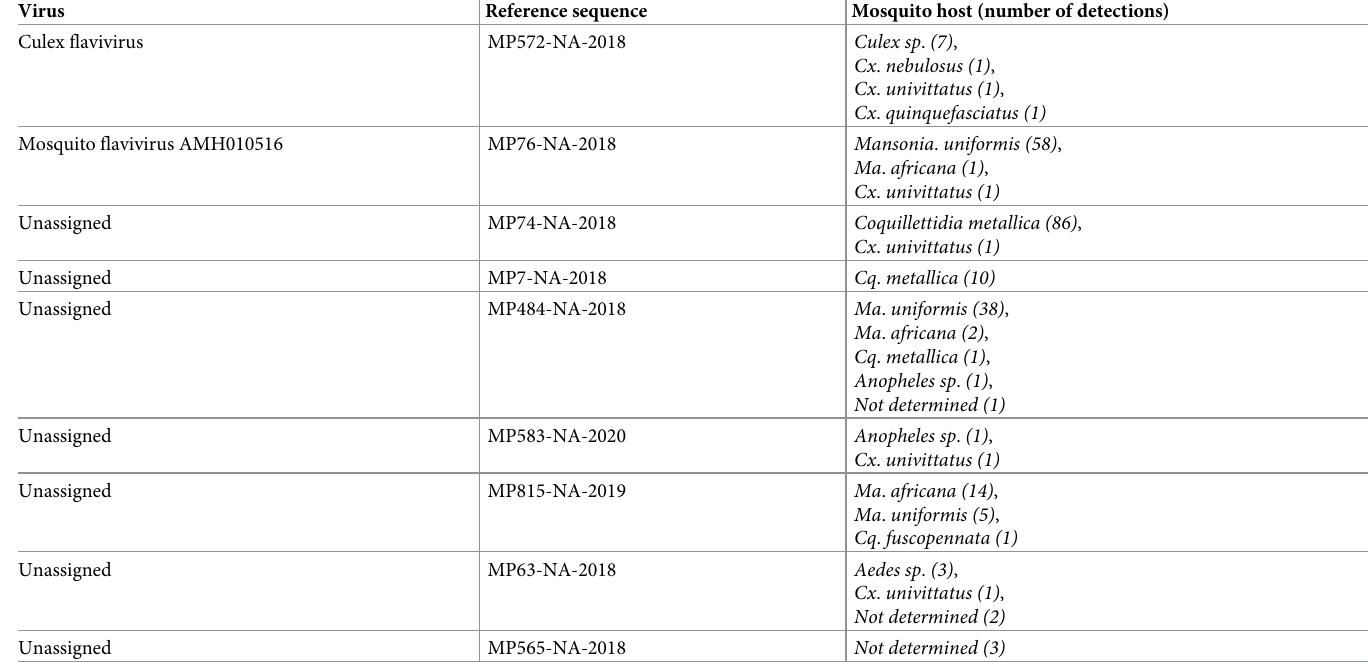
Table 1. Detected insect-specific flaviviruses in the Zambezi region, Namibia.